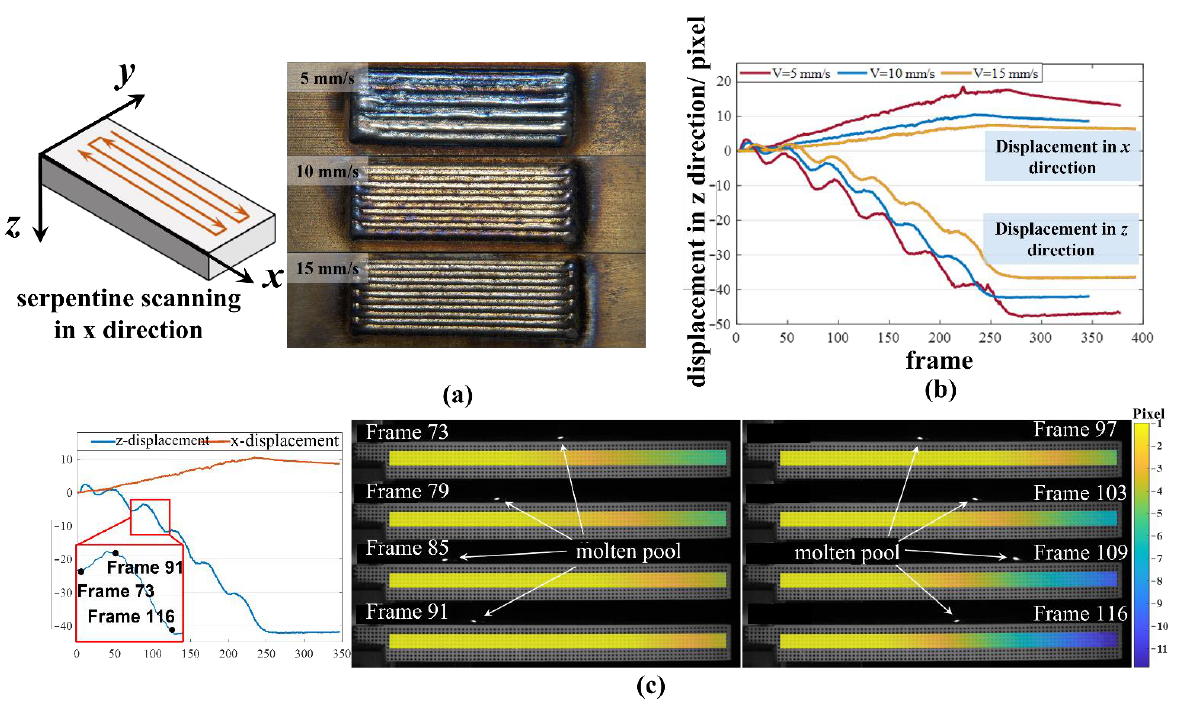
Figure 17. ( a ) Cladding results at different scanning speeds, ( b ) displacement evolution at different scanning speeds and ( c ) displacement field in z direction in a single cycle at 10 mm/s.